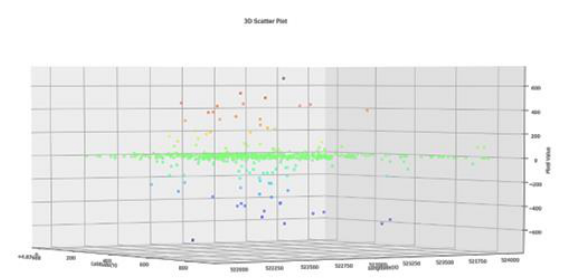
Figure 10 . Error value of the coincident pixels between the two data sources, with their UTM coordinates (WGS84 / UTM zone 28N).